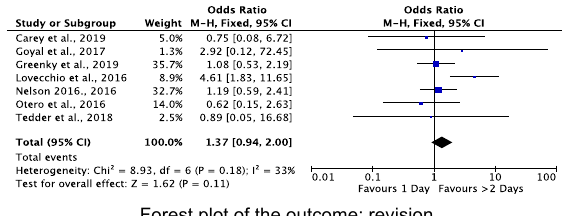
Forest plot of the outcome: readmission